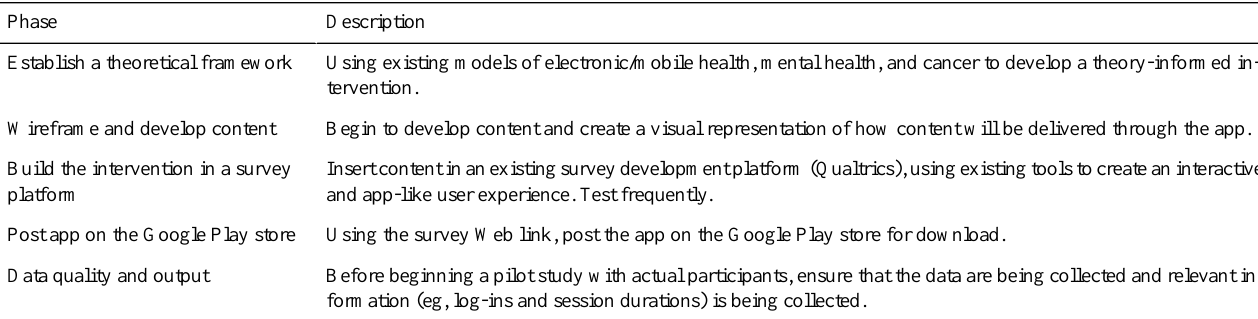
Table 1. General phases of app development using Web-based survey software.